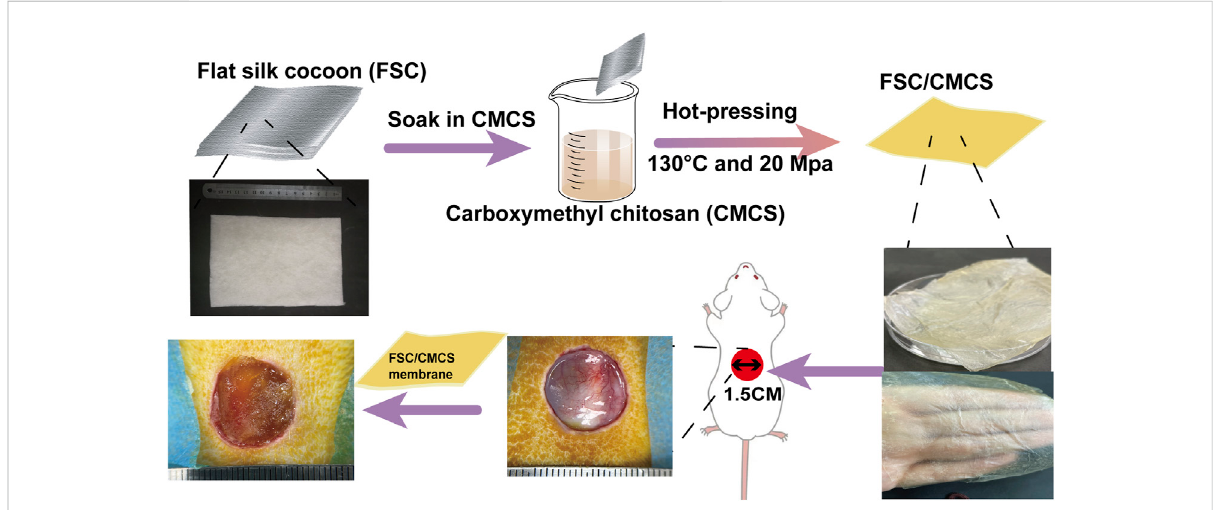
FIGURE 1 Illustration of the FSC/CMCS synthesis process and the use of FSC/CMCS as a wound